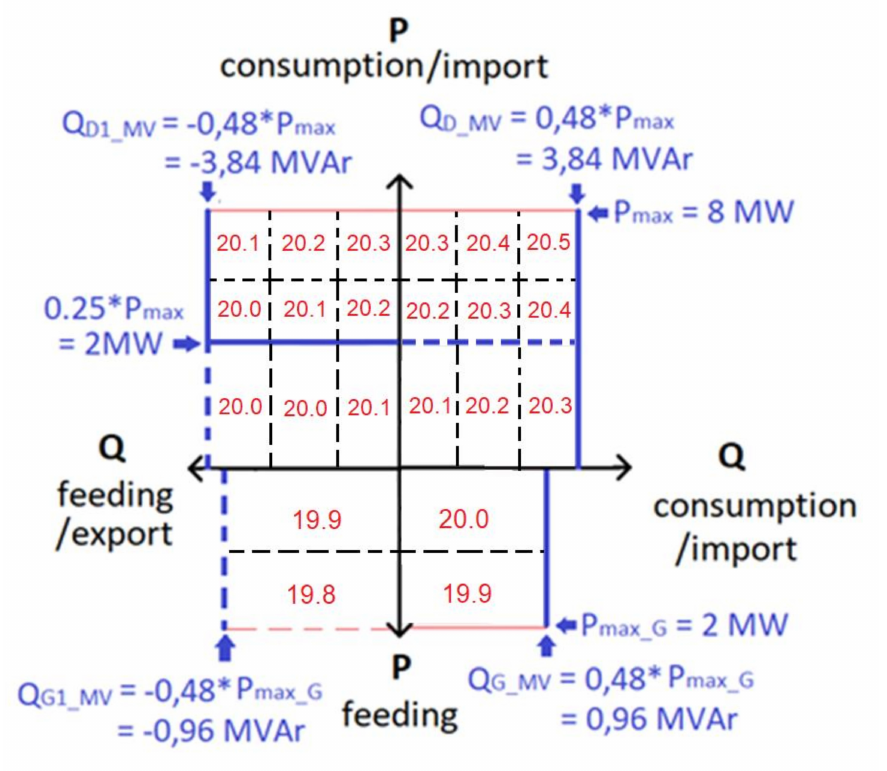
Figure 7. Real-time HV/MV substation PQ flow-dependent OLTC setting value (kV) with Sundom Smart Grid PQ flow limits (see Table 5 and Figure